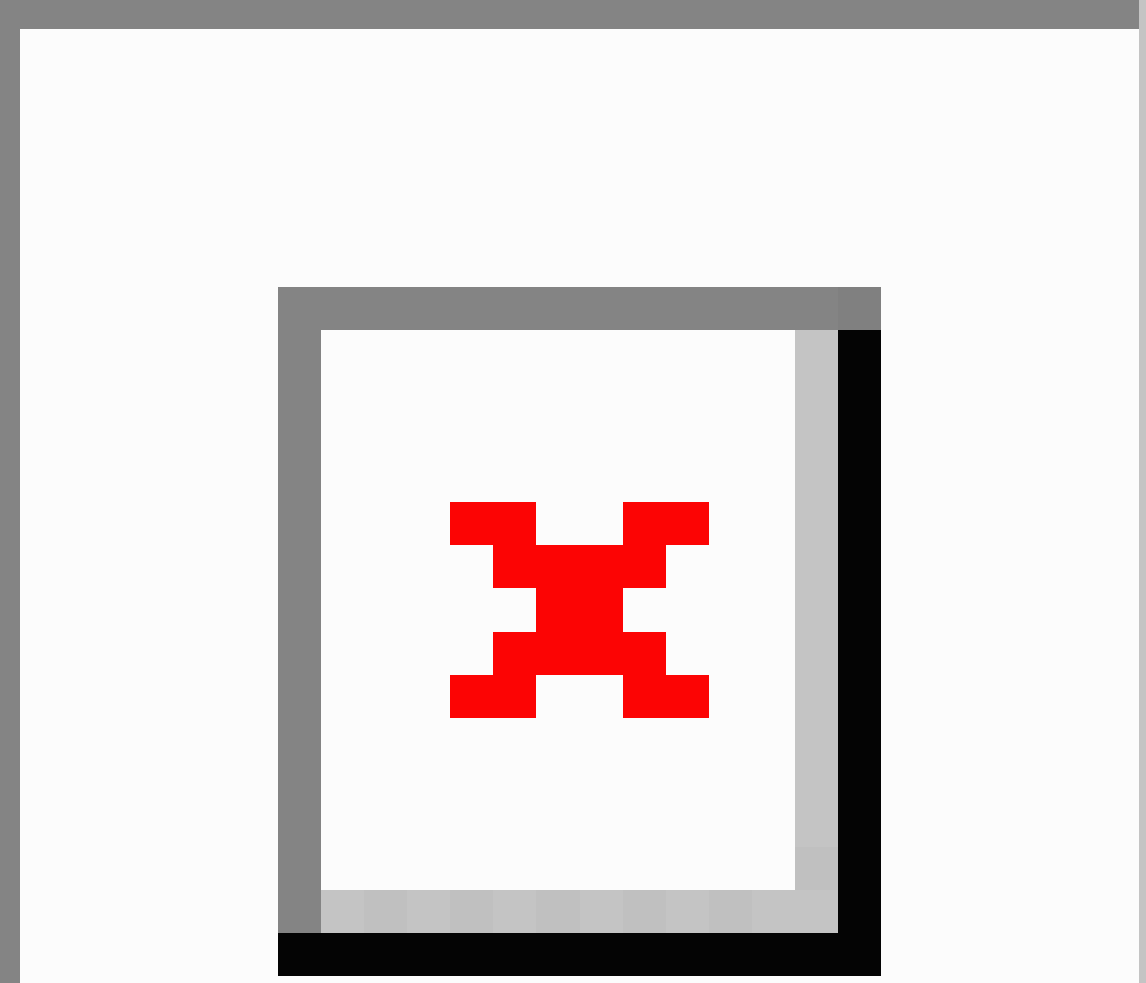
Figure 6. Overlay of pre-exposure prophylaxis (PrEP) services on the Atlanta ZIP Code map of the 5-year risk of new HIV diagnoses,